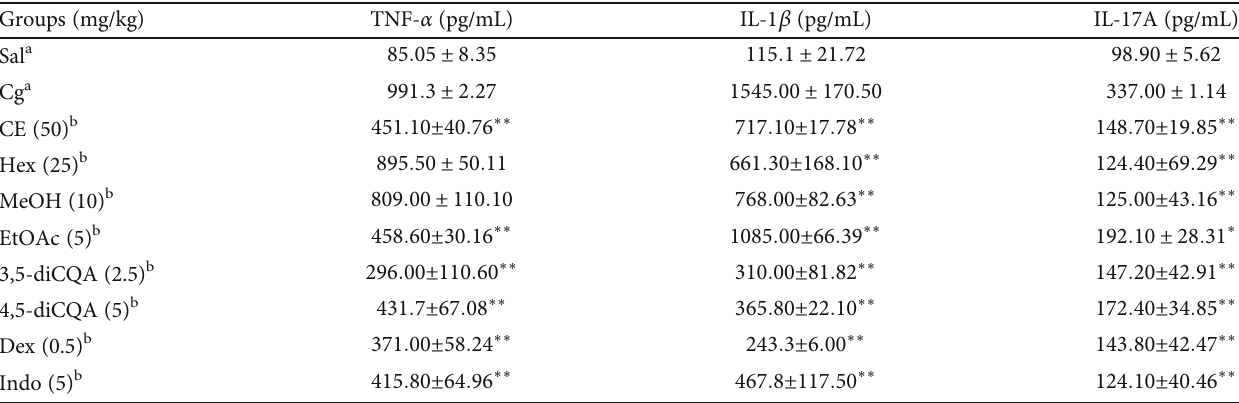
Crude extract (CE: 50mg/kg), hexane fraction (Hex: 25mg/kg), methanol fraction (MeOH: 10mg/kg), ethyl acetate fraction (EtOAc: 5mg/kg), 3,5-di- O - E - ca ff eoylquinic acid (3,5-diCQA: 2.5mg/kg), and 4,5-di- O - E -ca ff eoylquinic acid (4,5-diCQA: 5mg/kg) obtained from C . pinnati fi da leaves administered 0.5h before pleurisy induction. Sal: negative control group, animals treated only with sterile saline (0.95%); Cg: positive control group, animals treated only with carrageenan (1%); Dex: animals treated with dexamethasone (0.5mg/kg) 0.5h before pleurisy induction; Indo: animals treated with indomethacin (5mg/kg) 0.5h before pleurisy induction. a Administered by intra-pleural route (i.pl.). b Administered by intra-peritoneal route (i.p.). Each group represents the mean ± SEM of six animals. ∗ P < 0 : 05 and ∗∗ P < 0 : 01 .